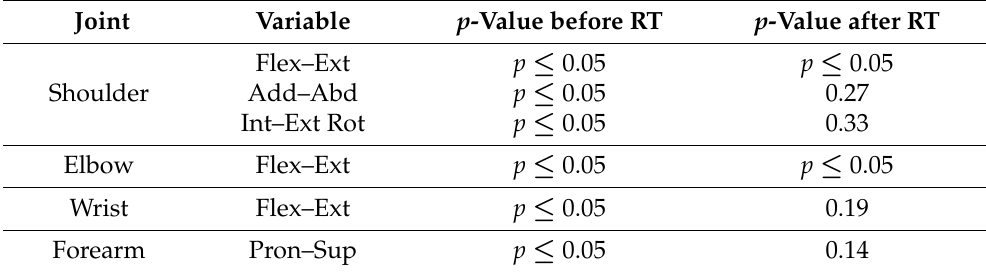
Table 8. Angular velocity Wilcoxon test of the paretic and non-paretic limb in the Maximum Forward Reach Test before and after the rehabilitation